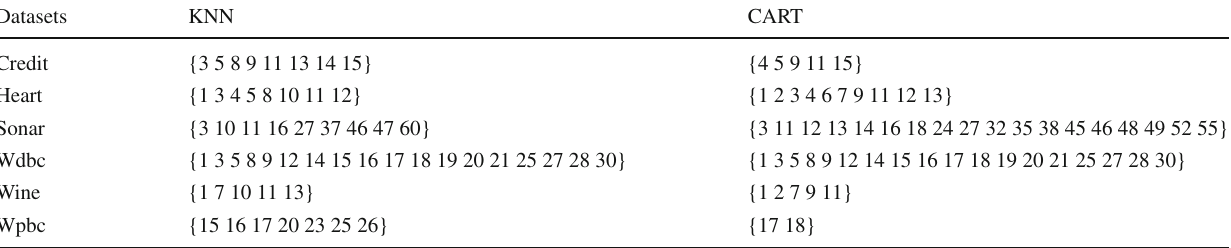
Table 4 Optimal feature subset with PTSIJE-FS for six UCI datasets